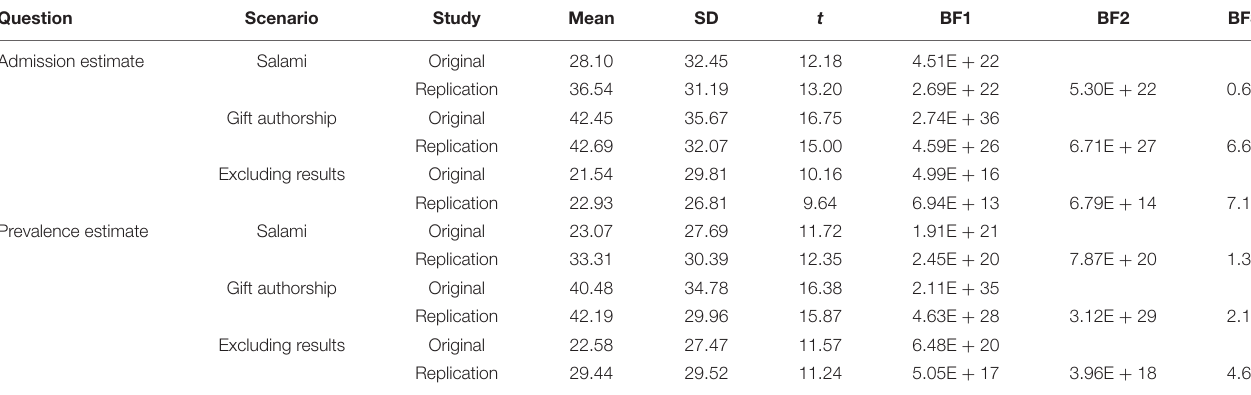
TABLE 3 | Results of the Bayesian test of replication where Original refers to Study 3 and Replication refers to Study